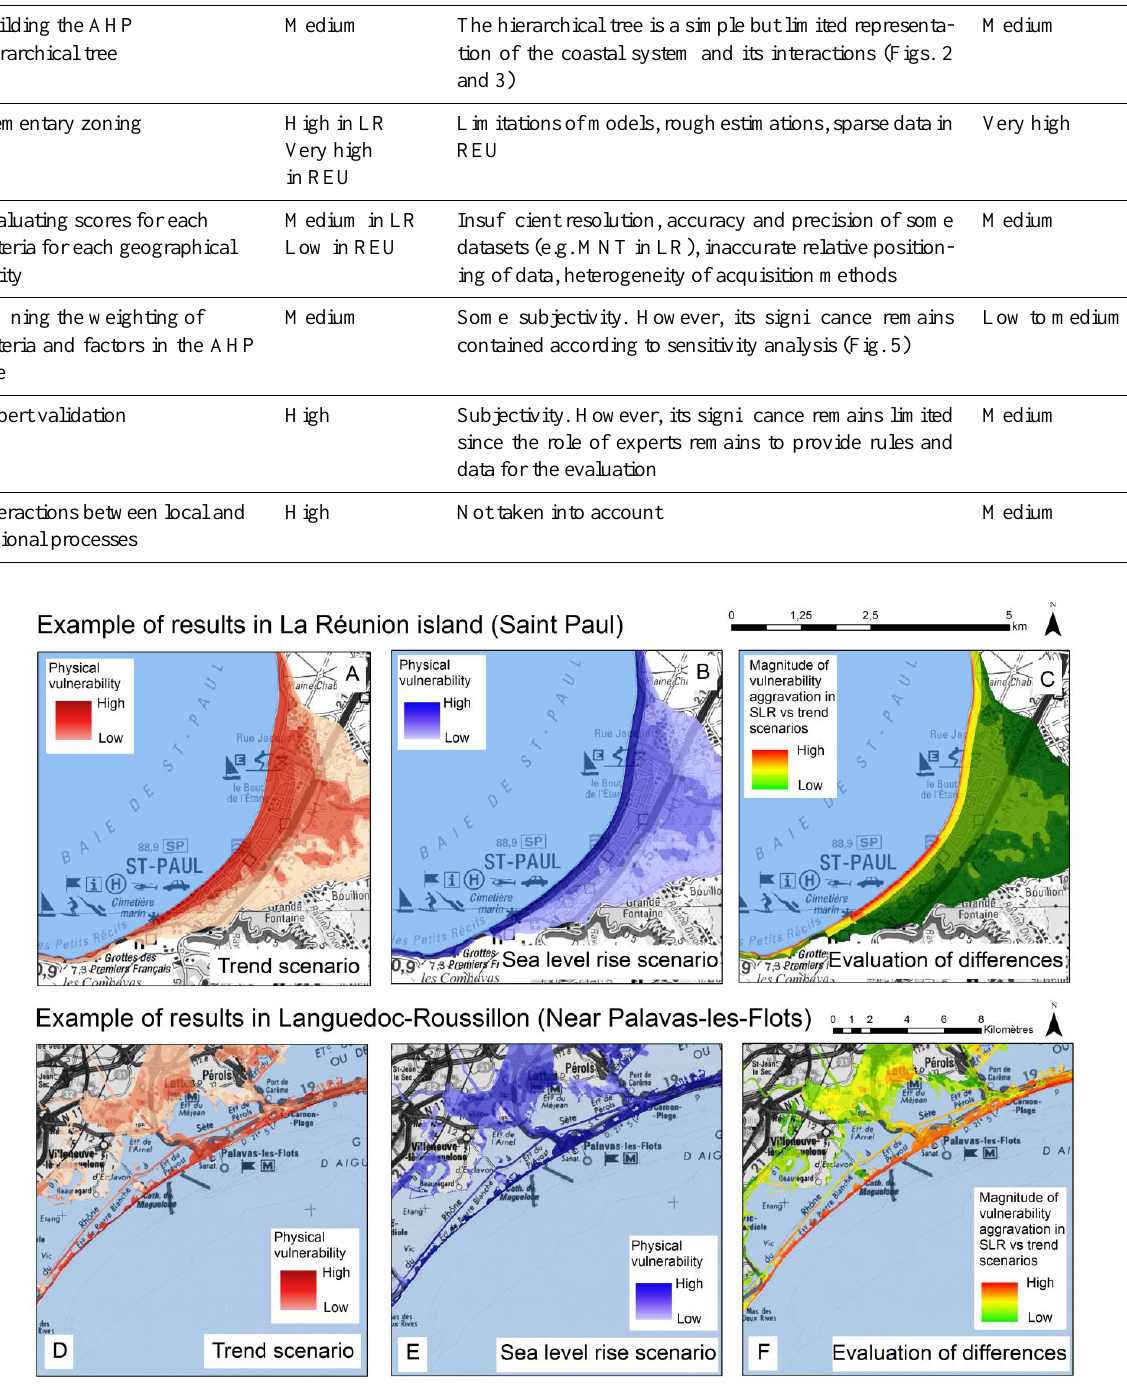
Fig. 6. Examples of results for La R´eunion (Saint-Paul) and Languedoc-Roussillon (near Palavas-les-Flots). The maps are provided for Figure 6: Examples of results for La Réunion (Saint Paul) and Languedoc-Roussillon (near 856 2 scenarios: sea level rise (A, D) and trend scenarios (B, E) . Maps C, F show areas where the physical vulnerability is expected to increase the most in the sea level rise scenario (Data: BRGM, Palavas-les-Flots). The maps are provided for 2 scenarios: sea level rise (A, D) and trend 857 scenarios (B, E). Maps C, F show areas where the physical vulnerability is expected to 858 increase the most in the sea level rise scenario (Data: BRGM, IGN). 859